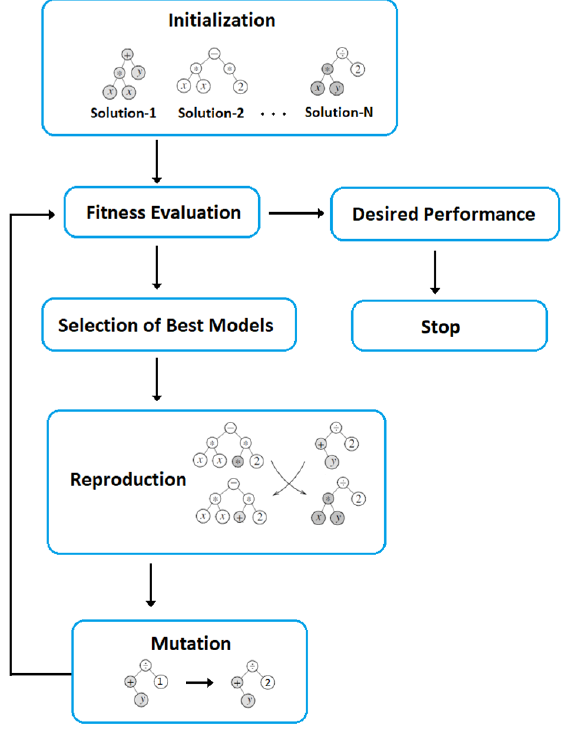
Figure 3. The procedure used to generate ET empirical equations using gene expression programming (GEP).